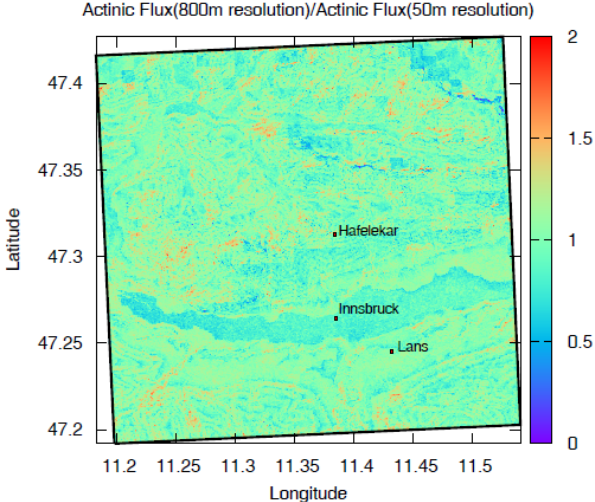
Fig. 10. Ratio of 3-D model actinic flux calculation using the 800m Figure 10: Ratio of 3-D model actinic flux calculation using the 800m DEM to actinic flux DEM to actinic flux calculation using the 50m DEM. Calculations performed at 305nm. calculation using the 50 m DEM. Calculations performed at 305 nm.